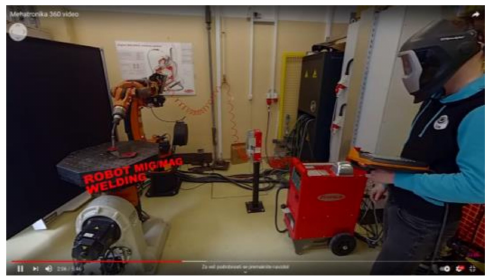
Figure 2. Motivational 360 VR movie example.